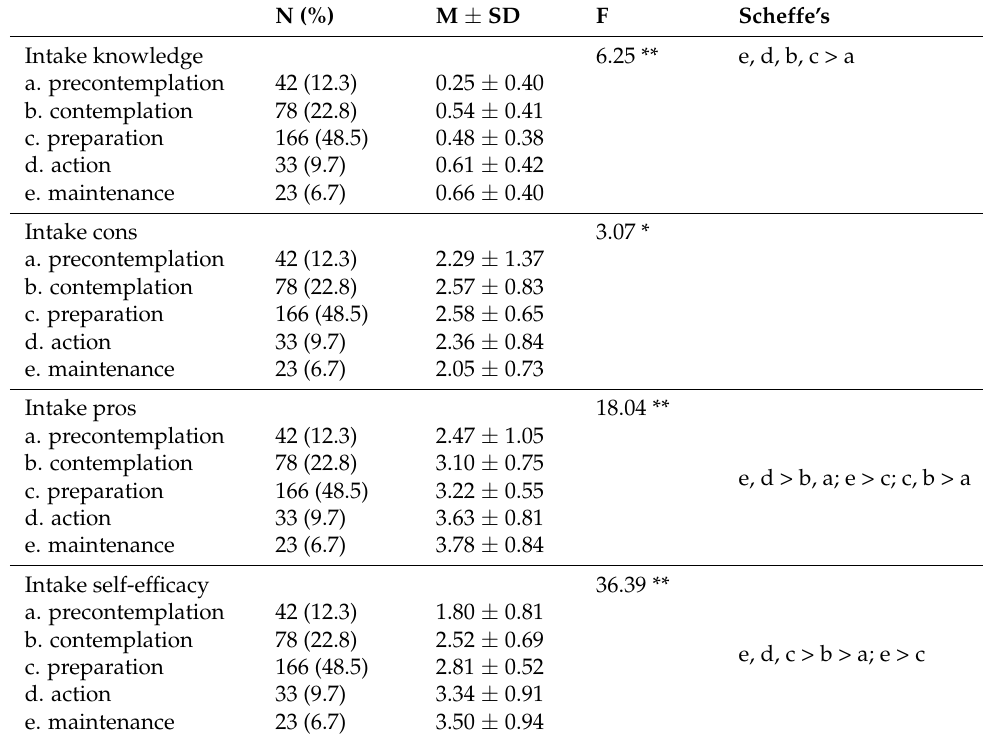
Table 3. MANOVA analysis between variables and stages of change (n =